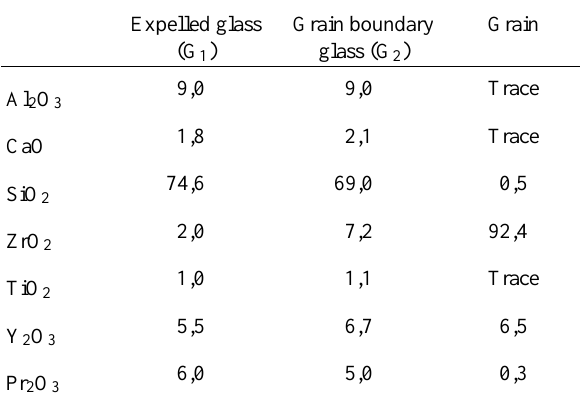
Table 2. Average compositions of grains and glass phase (mol %).